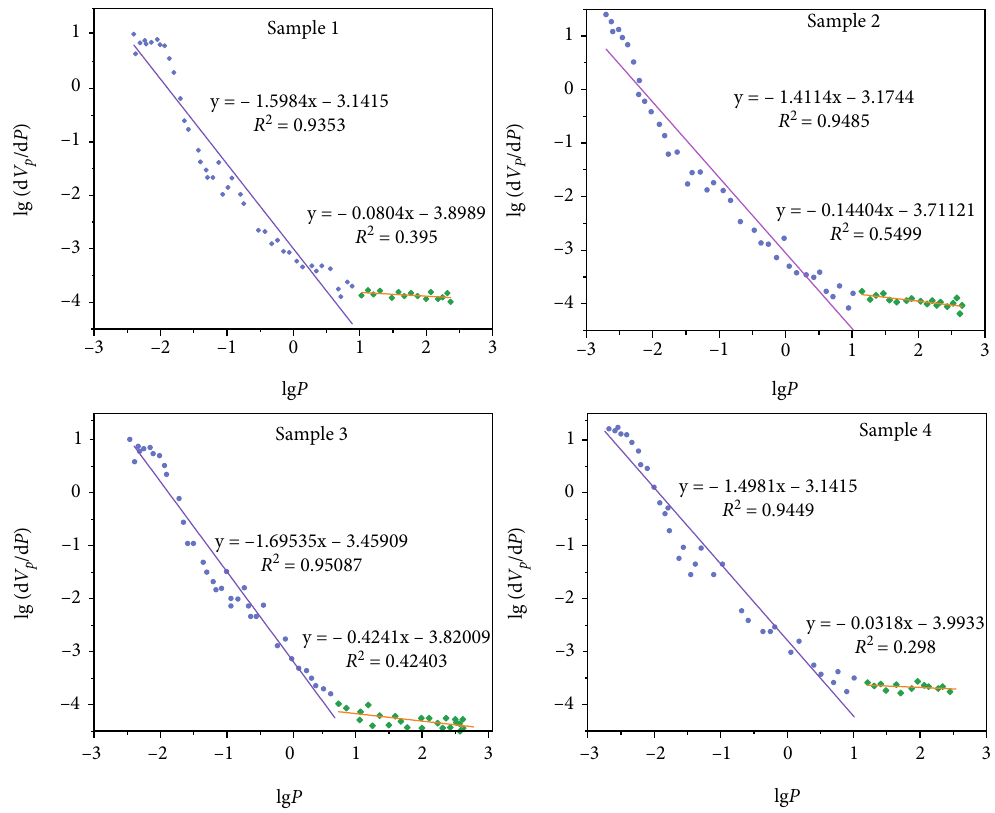
Figure 4: Fitting curves of mercury injection experimental data. Table 2: Fractal dimensions of the stochastic fractal model. Coal